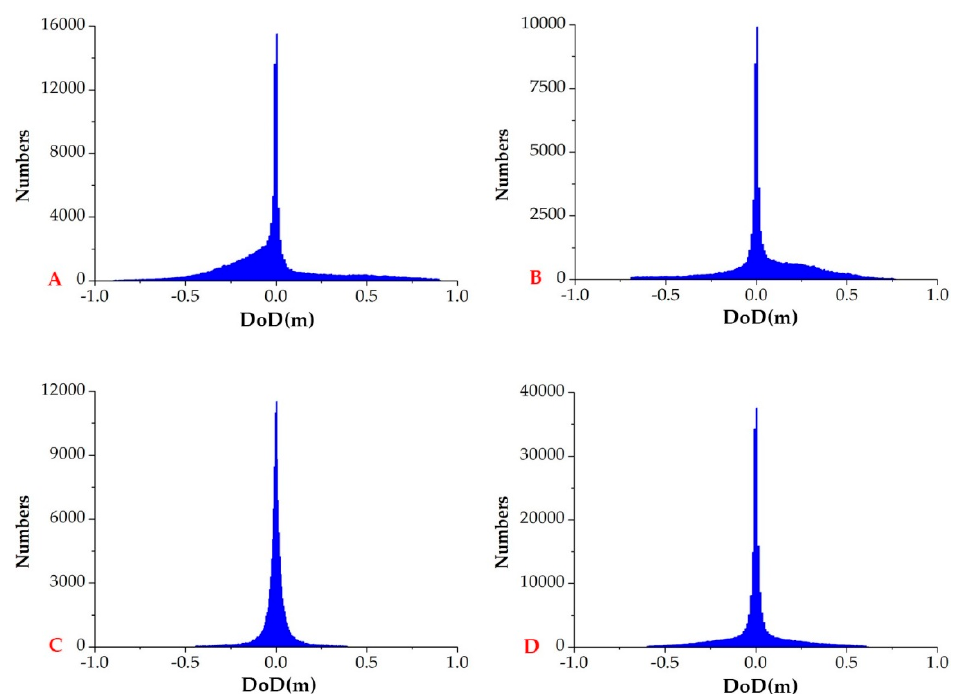
Figure 7. Histogram of DEM of Difference (DoD) values for four regions of the study area. On the basis of robust estimation, the specific areas experiencing topographical changes were detected. First, the variances of the DoD in the local sliding window were calculated. Second, the confidence level of the DoD was set to 99.7% to identify the areas with significant bathymetry variations. Figure 8 shows the spatial distribution of the identified topographical variations. In region A, a mix of erosion and light deposition was observed. The deposition was predominant in region B, and an increasing tendency was revealed along the wall. On the contrary, few topographical changes were observed in regions C and D. To better illustrate the bathymetry variation pattern, four representative profiles are shown for their DoD and bathymetry information (Figure 9).